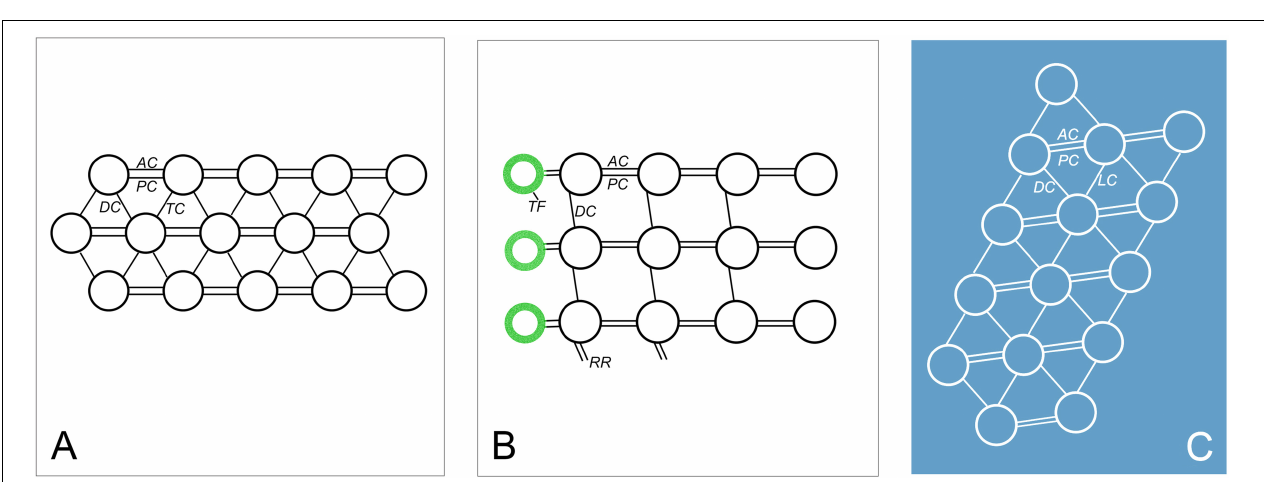
FIGURE 8 | Diagrammatic drawings of the connections of oral and somatic ciliature in Uronychia binucleata . (A) Scheme of caudal cirri and transverse cirri showing the anterior (AC) and posterior connections (PC) link kinetosomes in the same row, diagonals (DC) and transverse connections (TC) link kinetosomes in the next row. (B,C) Scheme representation of cross section of posterior part of adoral zone membranelles (B) and undulating membrane (C) . AC, anterior connection; DC, diagonals connection; LC, longitudinal connection; PC, posterior connection; RR, radial ribbon of microtubules; TF, terminal